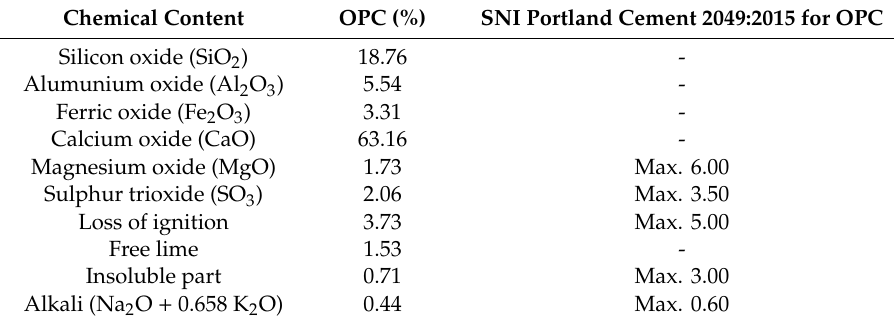
Table 3. Chemical content of OPC.